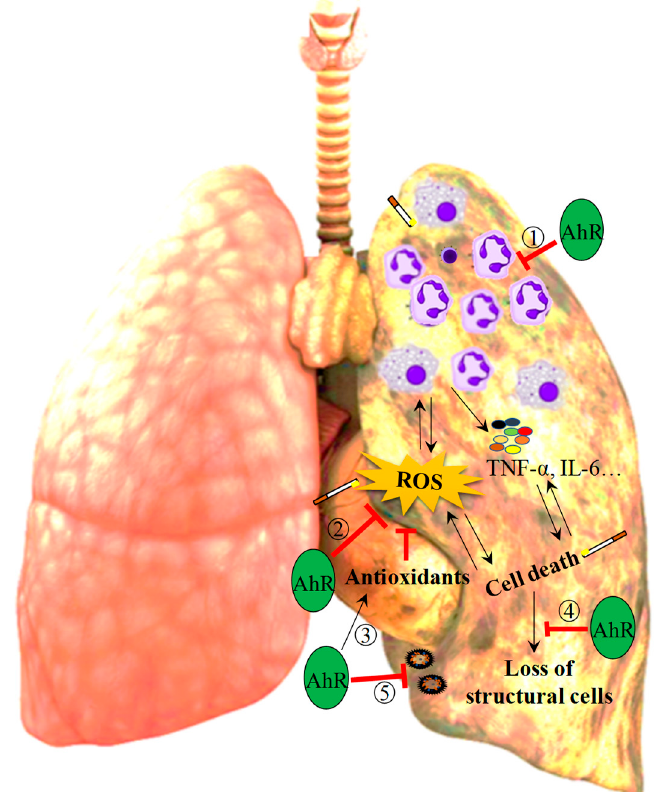
Figure 2. The AhR exerts protective effects in the lungs by attenuating CS-induced lung injury. The AhR attenuates an inter-connected web of pathogenic mechanisms that have been independently established to contribute to the progression of COPD. More specifically, the AhR may contribute to the attenuation of CS-induced inflammation via its role in (1) suppressing CS-induced pulmonary neutrophilia. Additionally, the AhR may attenuate CS-induced oxidative stress via its role in (2) suppressing CS-induced ROS production and (3) promoting the upregulation of anti-oxidants in response to CS. The AhR may also protect against CS-induced lung parenchymal destruction through its ability to (4) reduce the loss of lung structural cells by promoting cellular proliferation and attenuating CS-induced apoptosis and cellular senescence. (5) Finally, the AhR may protect the lungs against bacterial infections that could otherwise trigger COPD-associated exacerbations, such as S. Pneumoniae and P. aeruginosa , by promoting neutrophil infiltration. Black arrows represent promotion and red bars represent